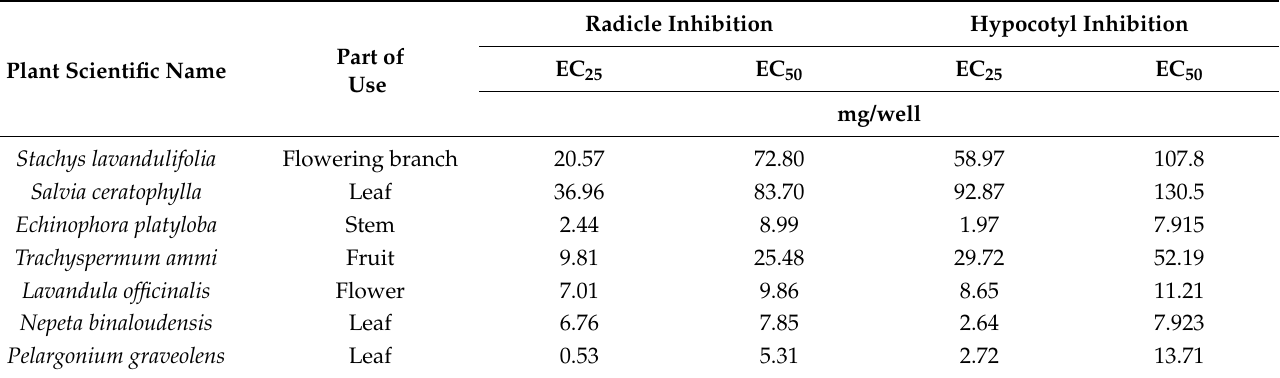
Table 3. The effective concentration of the most inhibitory plants on lettuce radicle and hypocotyl by dish pack